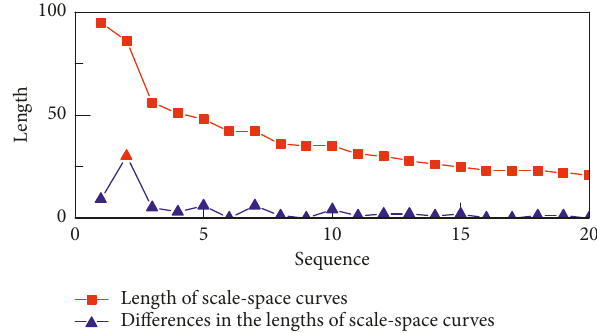
Figure 8: The lengths of scale-space curves and the differences in the lengths of scale-space curves.